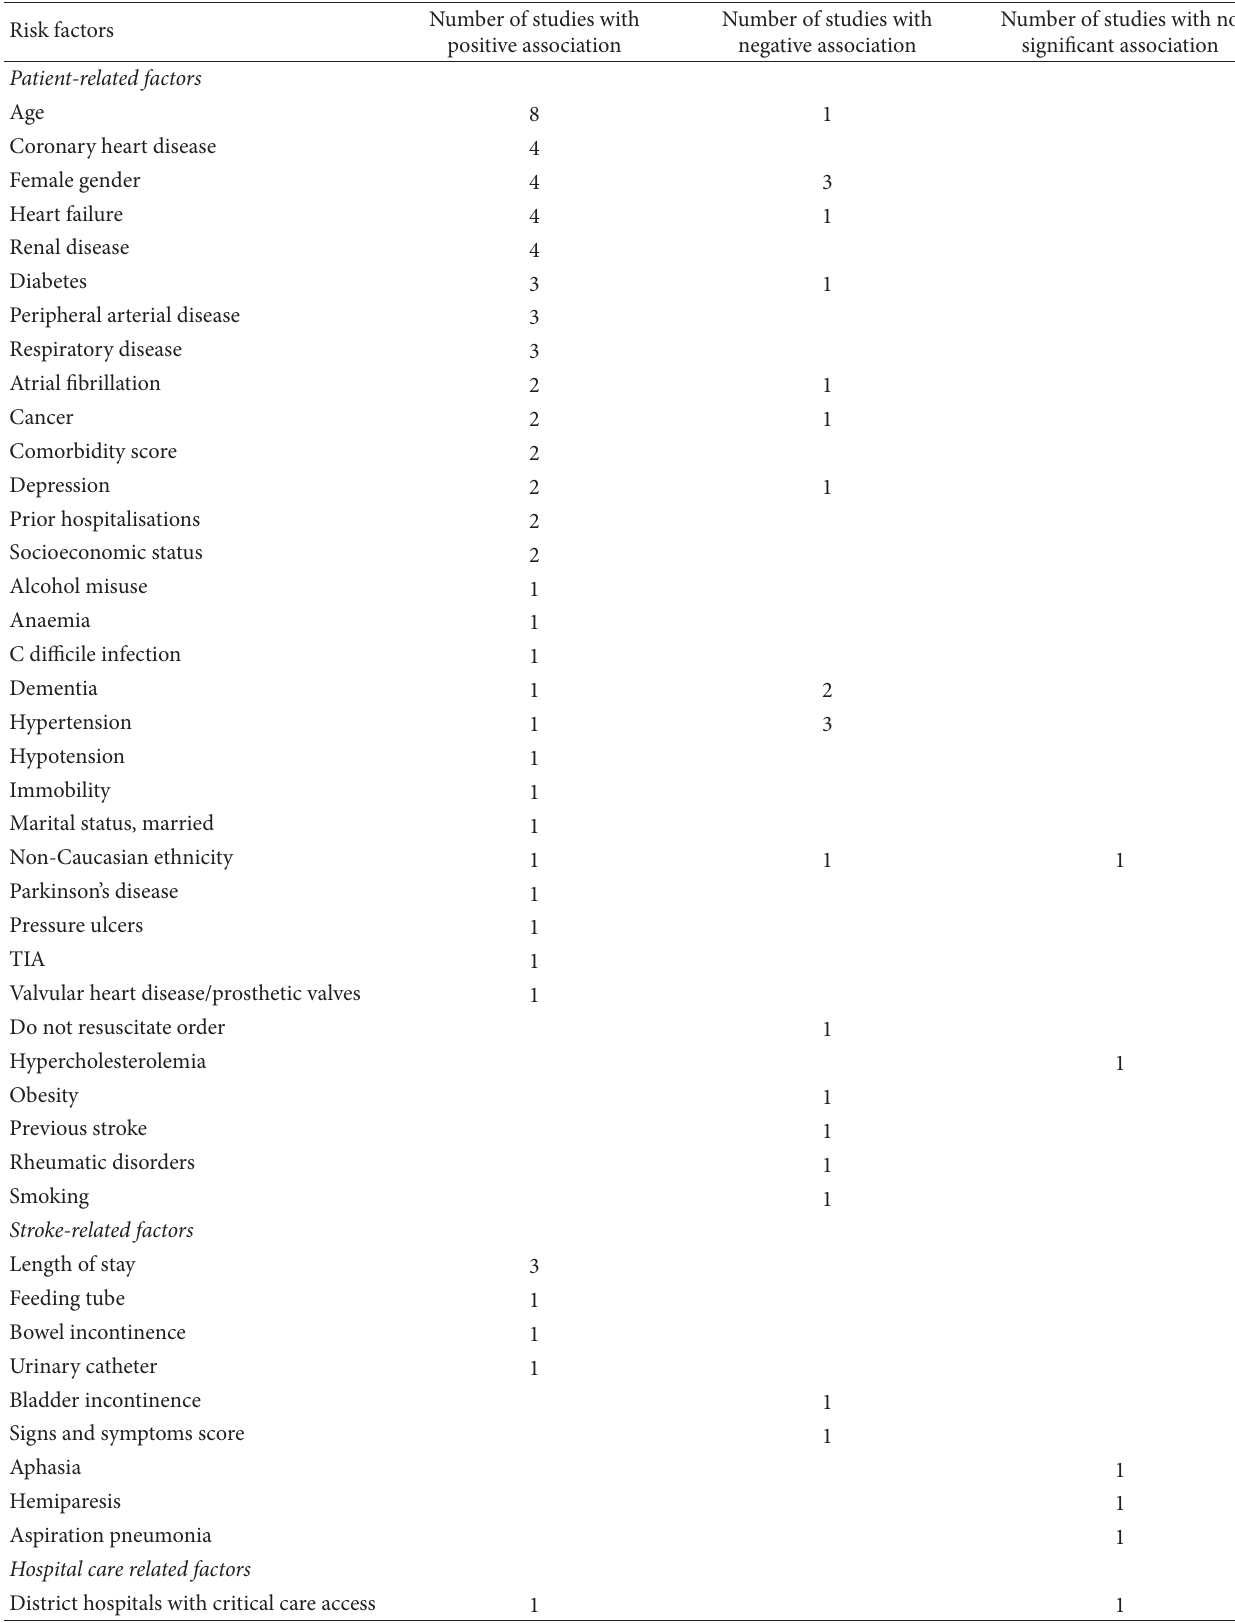
Table 4: Risk factors and their impact on all-cause, preventable, and cerebrovascular readmission rate. Risk